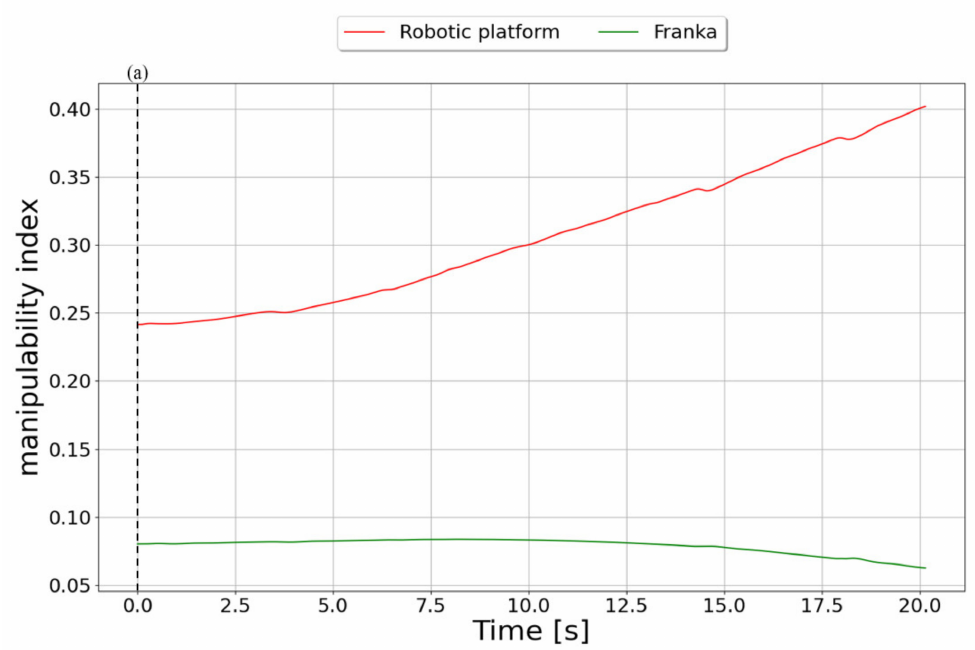
Figure 11. Cartesian position trajectory of the 8-DoF robot assistant during the execution of a linear trajectory along the Y - axis .